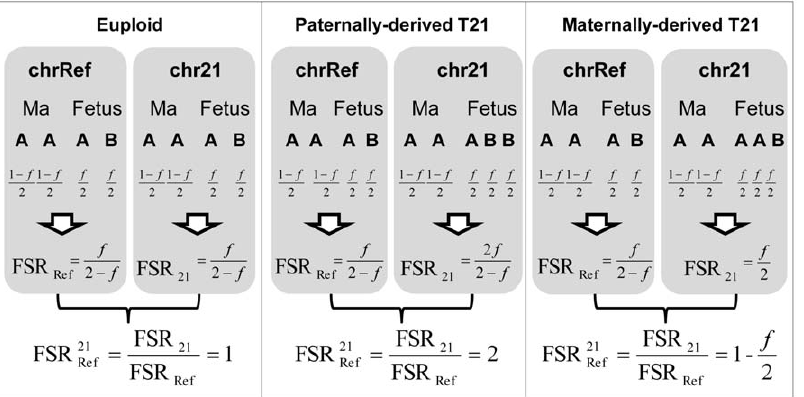
Figure 1. Schematic of T21 detection by F-S ratio calculation. Assuming the fractional fetal DNA concentration in chrRef is f, the F-S ratio would be f/(2-f) on chrRef irrespective of the aneuploidy status of the fetus. On the other hand, the F-S ratio on chr21 would be f/(2-f) if the mother is carrying a euploid fetus, 2f/(2-f) if the mother is carrying a paternally-derived T21 fetus, and f/2 if the mother is carrying a maternally-derived T21 fetus. Therefore, the FSR